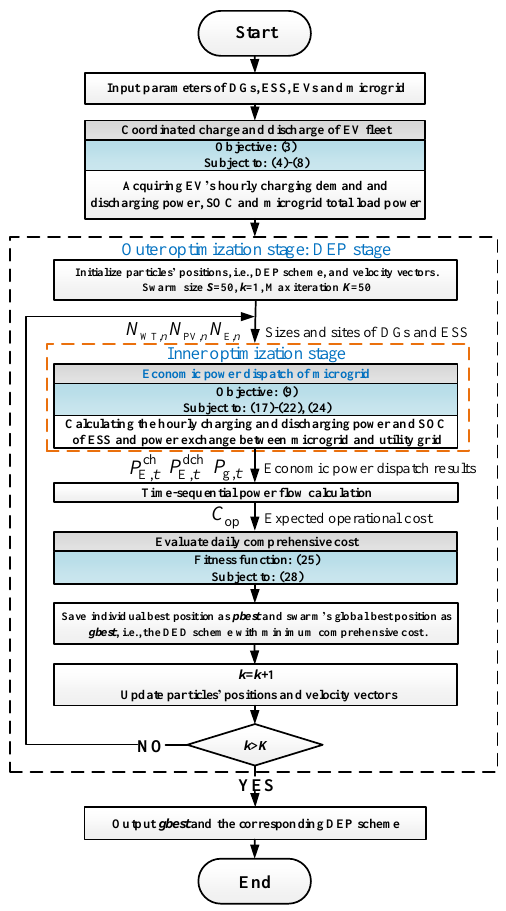
Figure 2. Flow chart of two-stage heuristic algorithm.